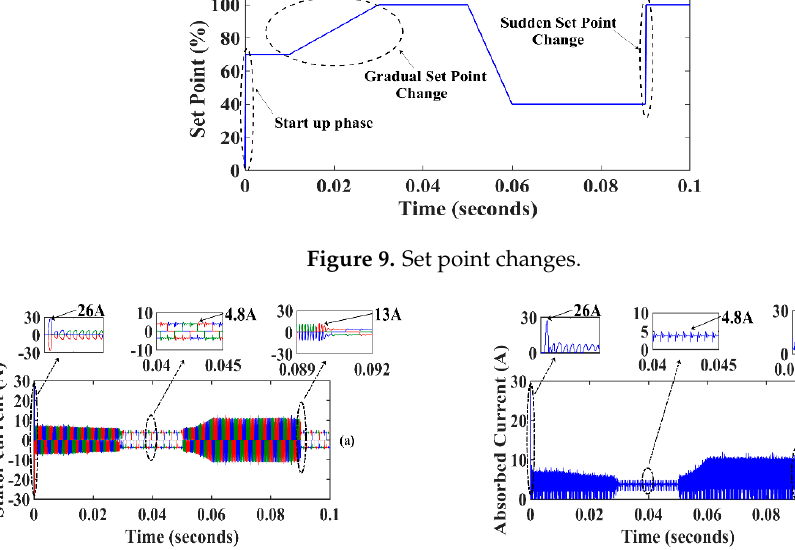
Figure 10. Current waveforms without R-C filter: ( a ) Phase currents, and ( b ) absorbed current.